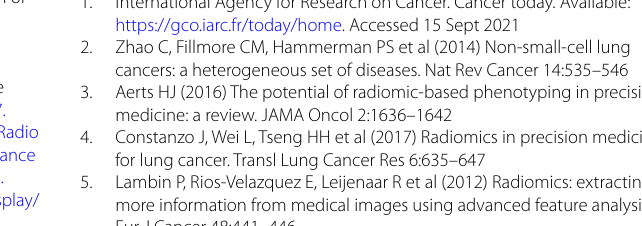
GLCM, Gray-level co-occurrence